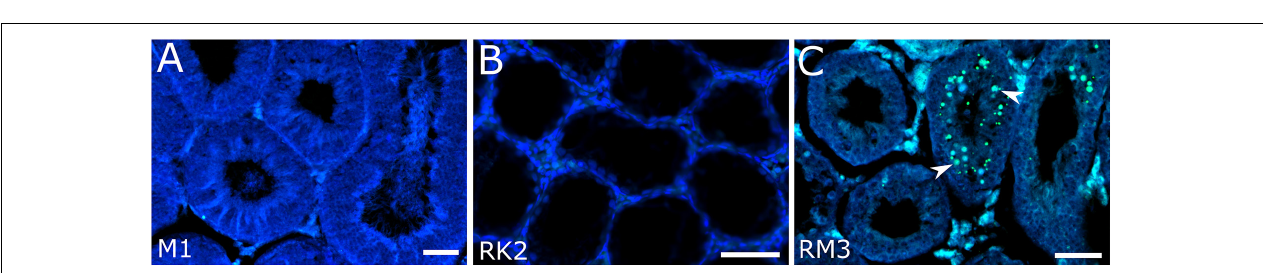
FIGURE 3 | Detection of apoptotic cells in seminiferous tubules in M. mystacinus (A) , M. rossiaemeridionalis × M. kermanensis (B) and M. rossiaemeridionalis × M. mystacinus (C) hybrids using TdT-mediated dUTP nick-end labeling (TUNEL). The blue channel is DAPI, the green channel is TUNEL. Arrowheads point to apoptotic cells. Letters and numbers in the bottom left corners of the graphs represent the type of cross and individual specimen number. Bar: 50 µ m.